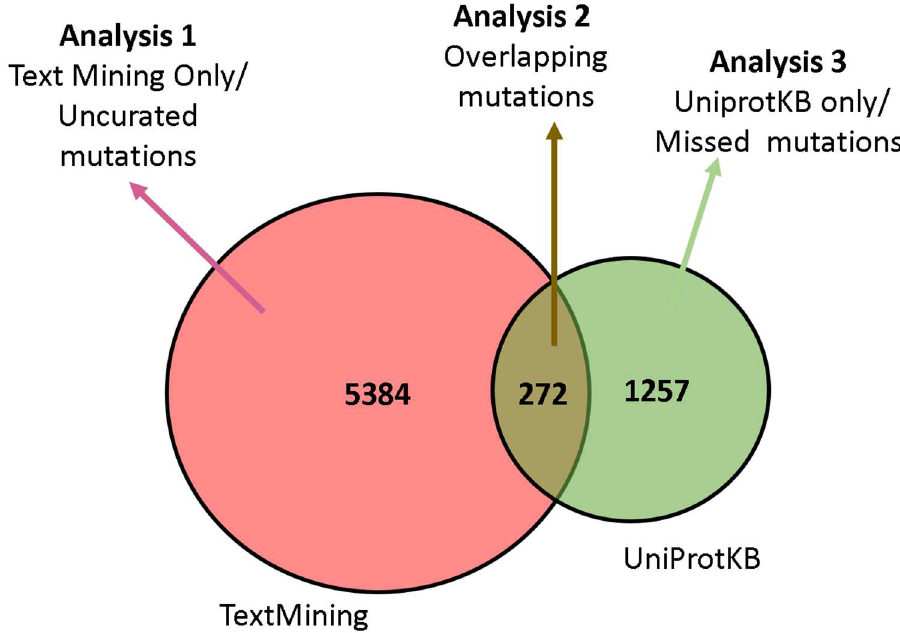
Fig 5. Three-tier analysis of text-mined vs. curated gene-disease-variant triplets.